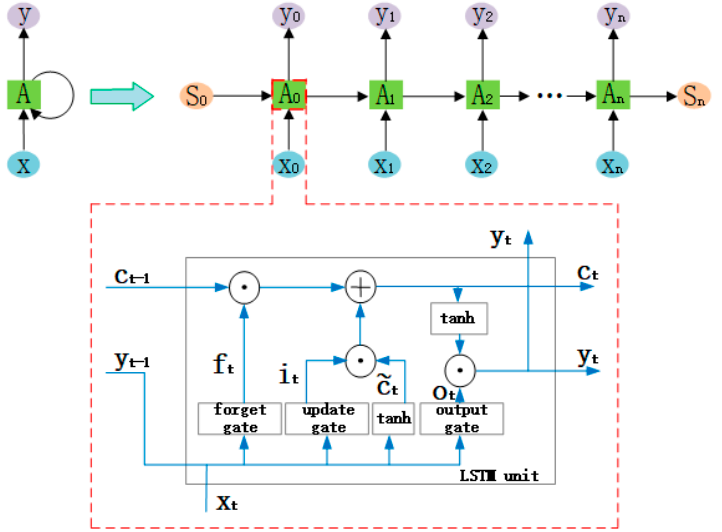
Figure 4. Structure of a single-layer long short-term memory (LSTM) neural network.